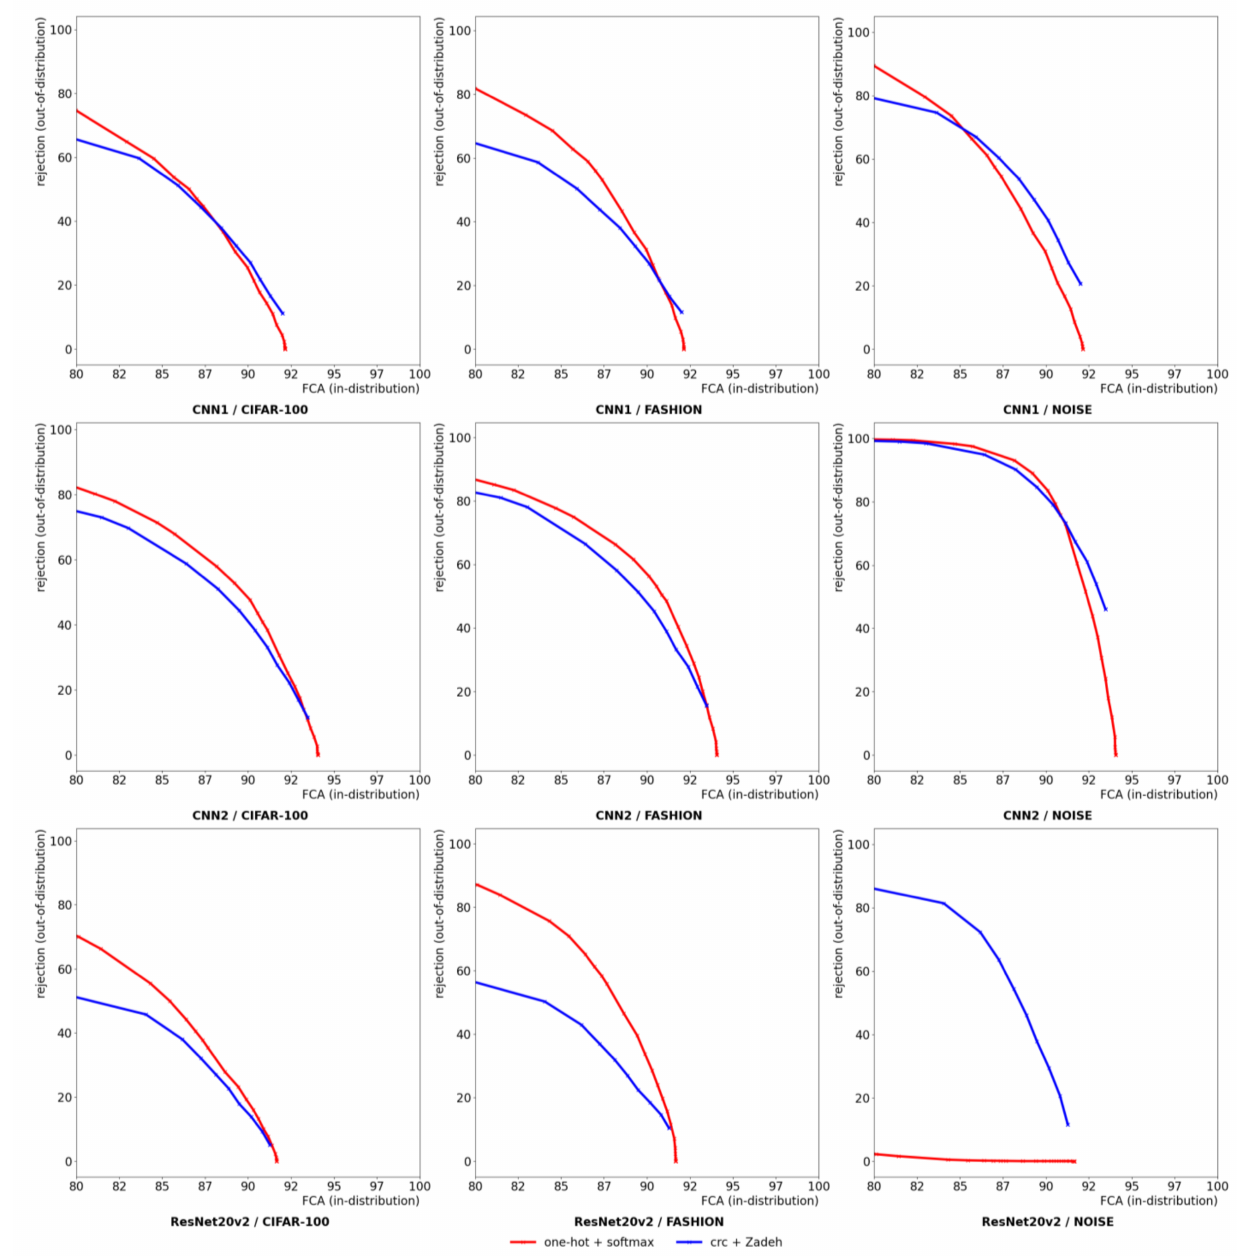
Figure 4. Out-of-distribution rejection (from left to right: CIFAR-100, Fashion MNIST, white noise) versus in-distribution FCA (full codespace accuracy) in studied networks and decision